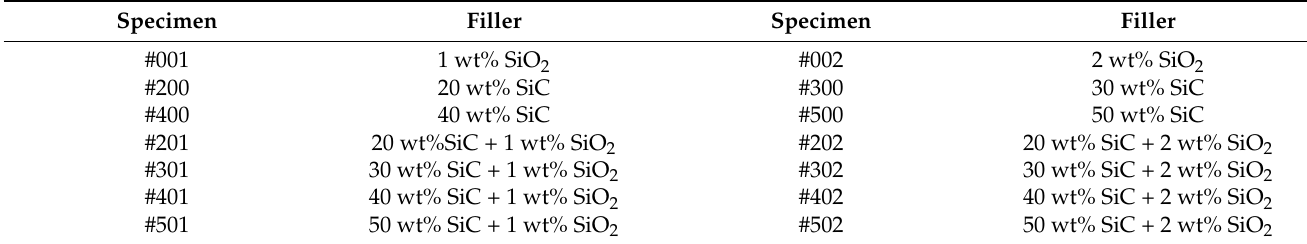
Table 1. Material ratio of orthogonal composite